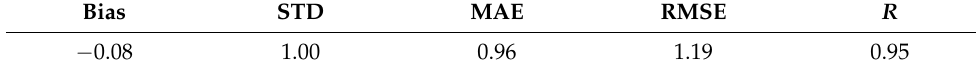
Table 1. The ZTD outer accuracy (cm) between IGS and VMF collocated stations. Bias STD MAE RMSE